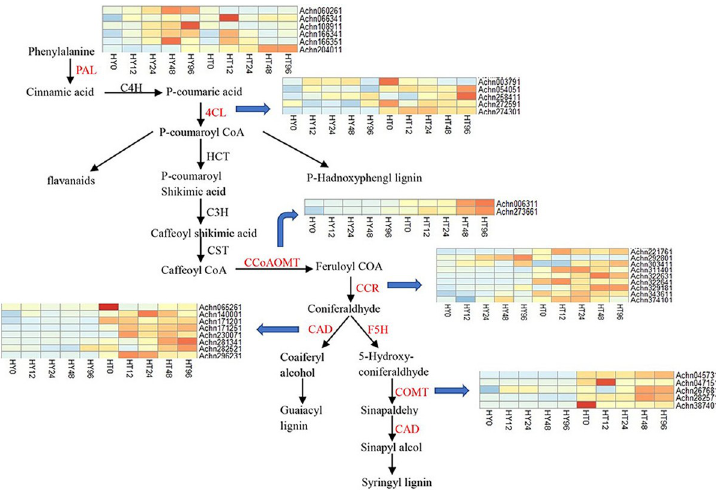
Fig 7. Expression patterns of the DEGs involved in the biosynthesis of phenylpropanoid at different time points (0, 12, 24, 48, and 96hai) in response to Psa infection in Huate (HT) and Hongyang (HY). Gene expression level was measured using the FPKM method (expected number of fragments per kilobase of transcript sequence per millions of base pairs sequenced). Heat map shows the expression of genes ranging from blue (low expression) to red (high expression). The expressed genes represented are phenylalanine ammonia-lyase (PAL), 4-hydroxycinnamoly CoA ligase (4CL), cinnamyl alcohol dehydrogenase (CAD), cinnamoyl-CoA reductase (CCR), caffeoyl-CoA O- methyltransferase (CCoAOMT), and caffeic acid 3-O-methyltransferase (COMT).